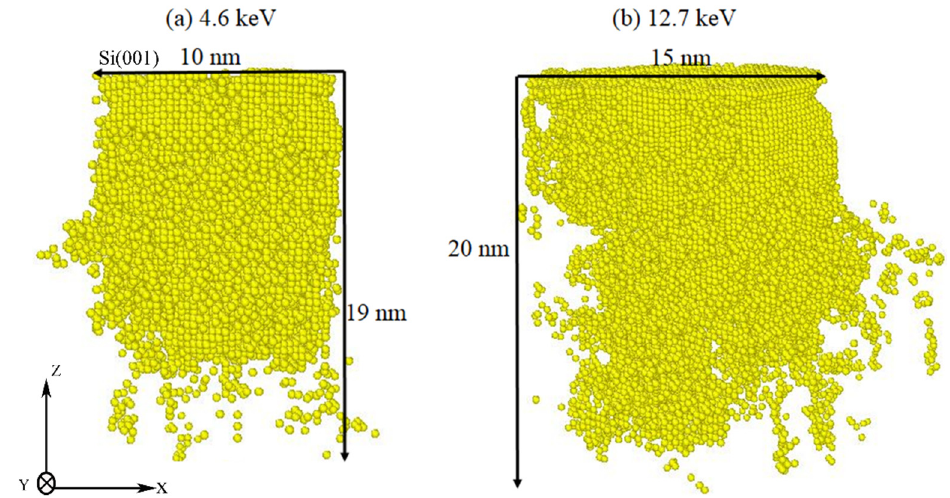
Figure 5. Cross-sectional views of vacancies’ evolution in the silicon target during ( a ) 4.6 keV and ( b ) 12.7 keV Si 35 cluster implantation at 0.5 ps. The yellow dots represent vacancies. The top surface is the Si (001) plane.